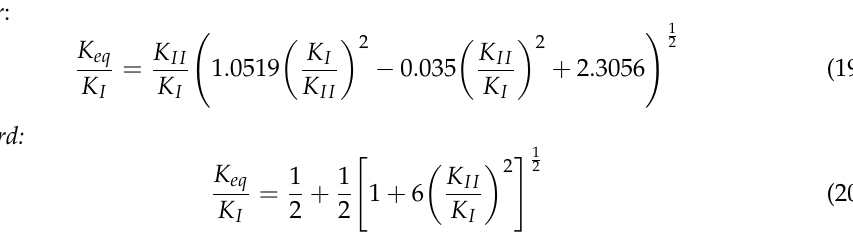
Figure 1 plots the non-dimensional K eq / K I as a function of K I / K II for the approaches considered, in a region K I / K II < 2. Figure 2 plots the non-dimensional K eq / K I as a function of K II / K I for the approaches considered, in the region K II /K I < 5.